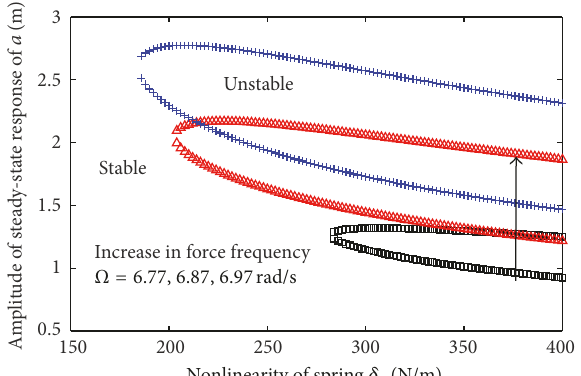
Figure 11: The effect of varying force frequency Ω on unstable area of vibration 𝑎 . Ω = 6.72 rad / s (black squares), Ω = 6.77 rad / s (red triangles), and Ω = 6.82 rad / s (blue crosses).